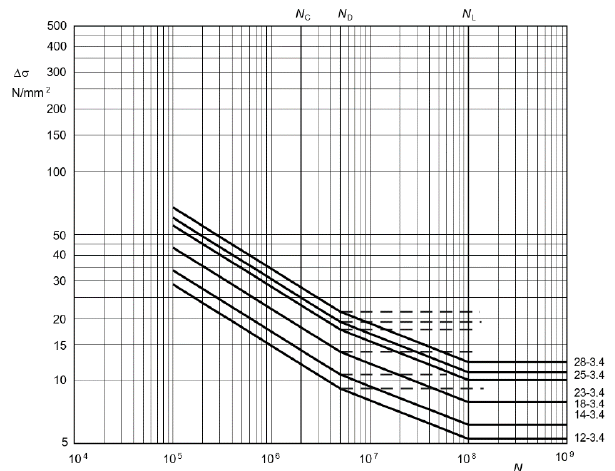
Figure 6. S-N curves for T-shaped welded joint and lap fillet-welded joint [23].